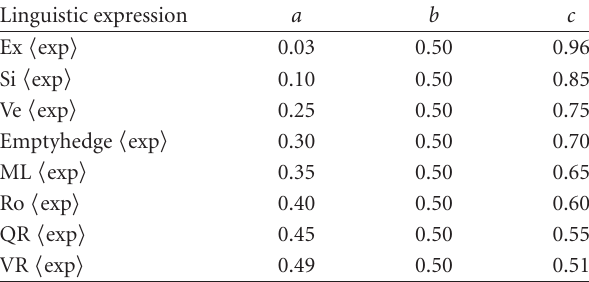
Figure 5. In the first sub-process we use the AprioriGen algorithm for selecting the candidate fuzzy association